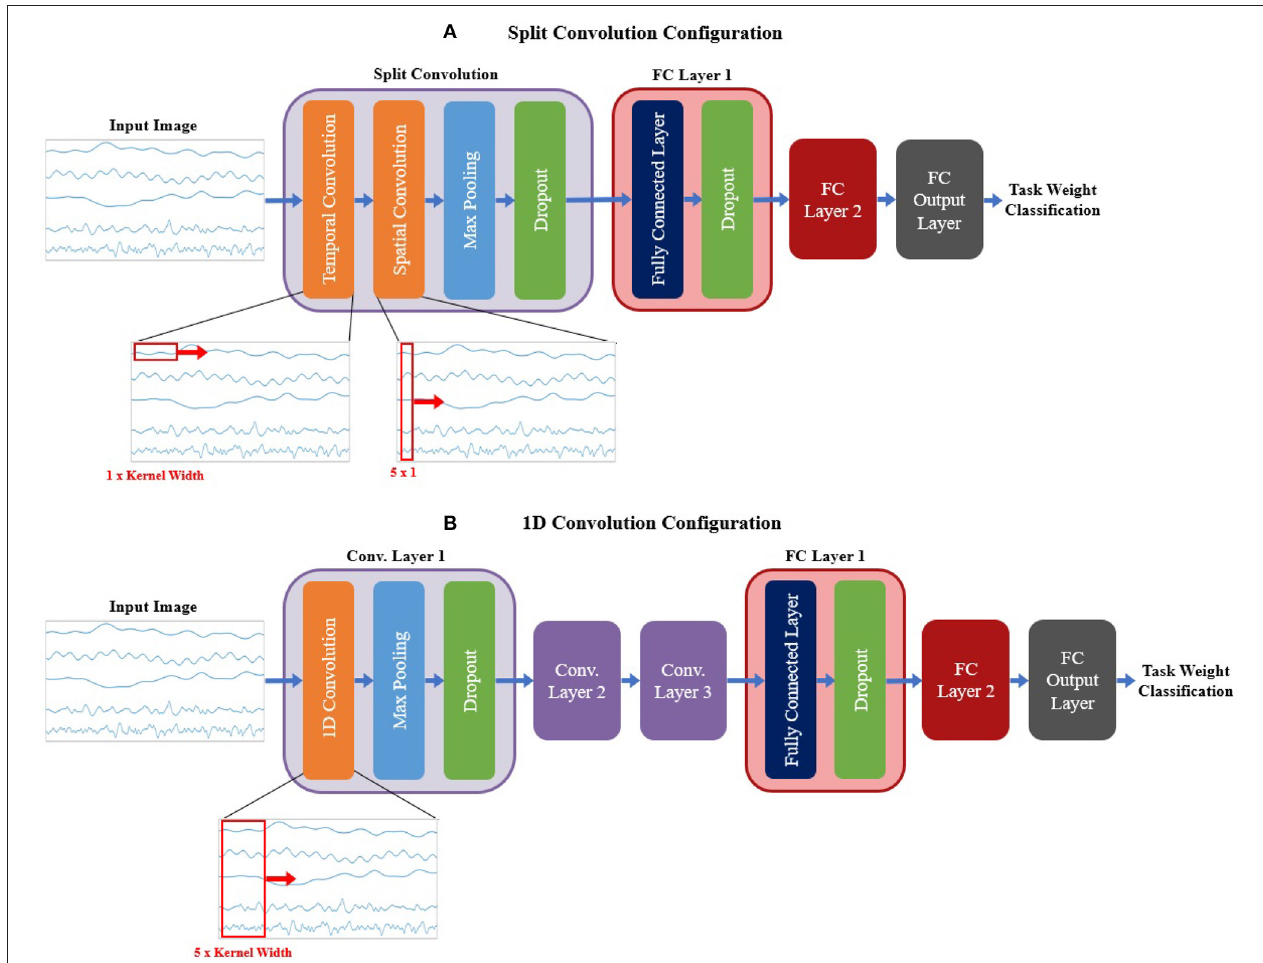
FIGURE 6 | The base model configurations used for the (A) split convolution and (B) 1D convolution models. Visual representations of the differences between both convolution types are shown in the expanded view below each diagram, detailing the changes in kernel size used to facilitate both types of convolution. Split convolution used one split convolution layer comprised of temporal and spatial convolution sub-layers, followed by a max pooling and dropout sub-layer. 1D convolution used three convolution layers, each with three sub-layer steps (convolution, max pooling, and dropout). All signal model types followed convolution with two FC layers (containing two sub-layer steps: the FC step followed by dropout) and an output FC layer to perform the final classification. Note, that repeated layers only show the sub-layers for the first layer, to reduce redundancy and condense the